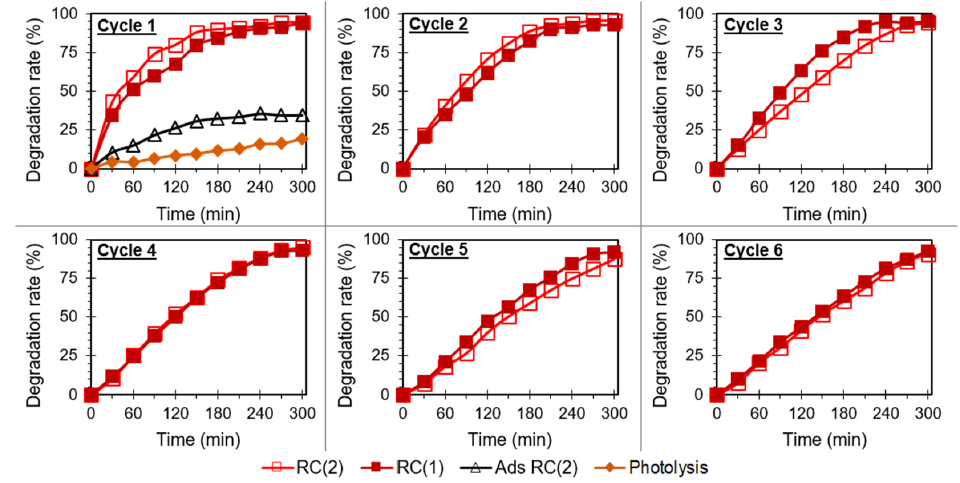
Figure 3. Photolysis degradation rate, adsorption rate in the dark (Ads), and photocatalysis degrada- tion rate as a function of time for MO under artificial solar light in the presence of RC(2) or RC(1) for subsequent experiment cycles.